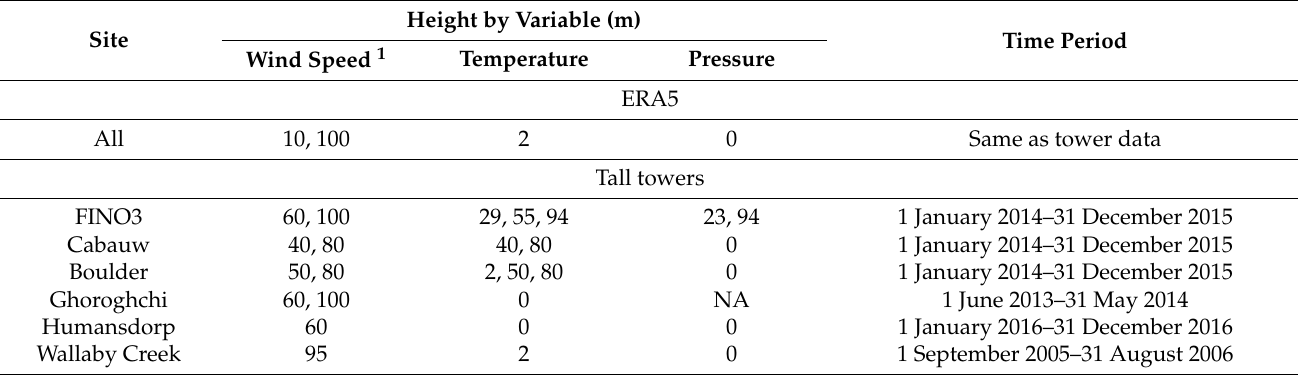
Table 2. Variables by height and period of time series used at each site for ERA5 and tower data.